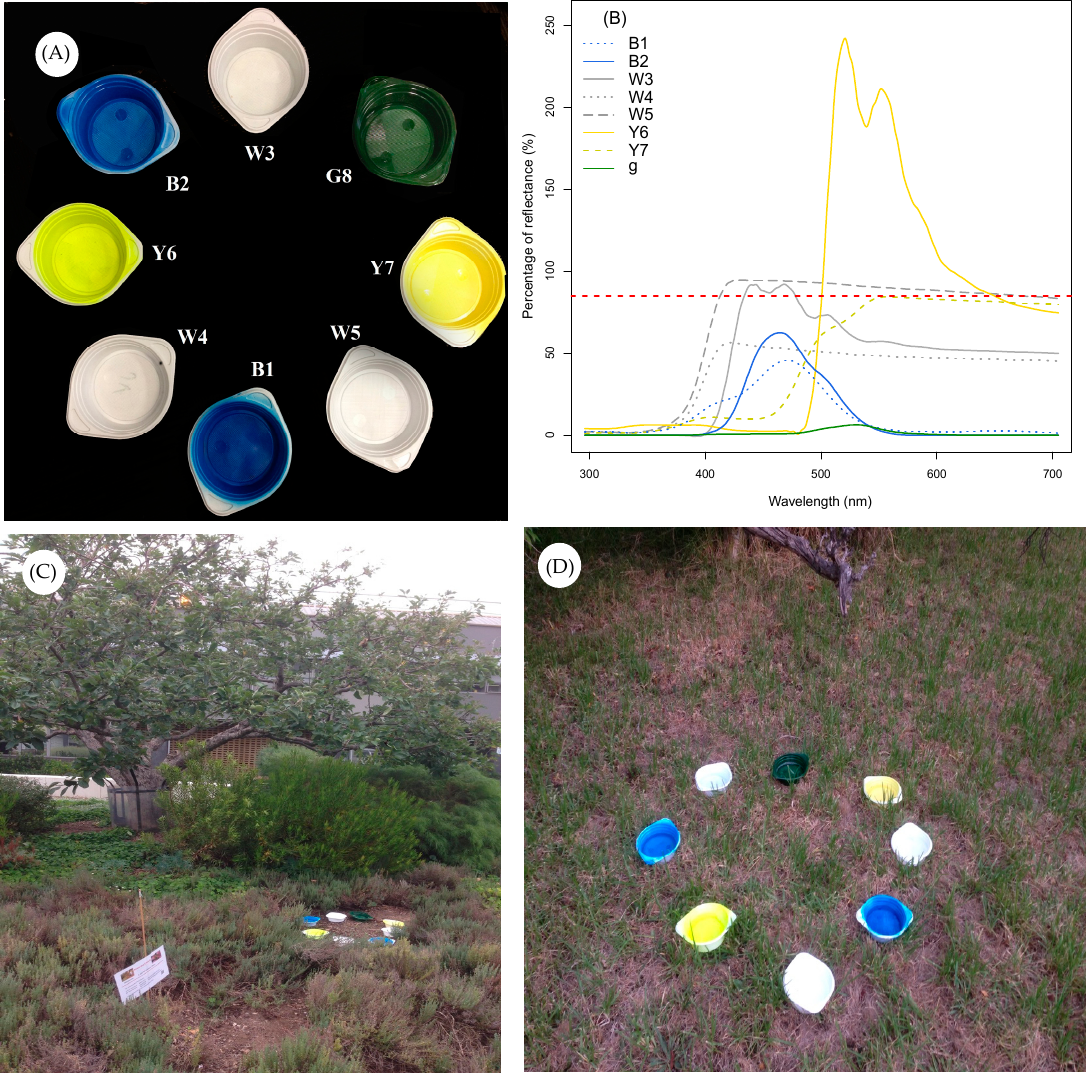
Figure 2. The pan trap experiment: ( A ) The pan trap bowls with eight different human perceived “colours”, ( B ) the percentage of reflected radiation plotted against wavelength for each pan trap “colour” type (See Table 1 for details and the different treatments involved for each pan trap type). The red dotted line shows the 90% threshold for categorisation as fluorescent or non-fluorescent stimuli, ( C , D ) the pan traps in the sample field settings.